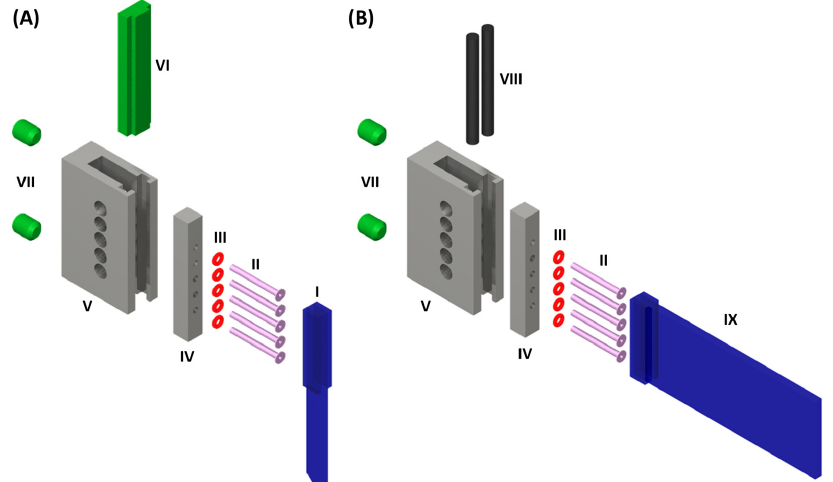
Figure 4. Exploded view scheme of the connector interfacing fluidic devices and the tubing: ( A ) Fluid connector assembly for DMPT. ( B ) Fluid connector assembly for other planar microfluidic devices. (I) Droplet sampling tool; (II) Flanged PTFE-Tubing (1/16” OD, 0.5 mm ID, ca. 4 mm flange radius); (III) Rubber O-rings; (IV) Aluminum crossbars with through holes for the tubing; (V) Aluminum main frame with side openings for visual adjustment of tube to device alignment. Tapped holed for the grub screws (VII) and groove inside for the plastic support (VI) for the fluidic device. (VIII) Rubber sealing cord, (IX) planar microfluidic chip with fluid inlets on the face-side. The fluidic devices (I) and (IX) are planar due to their manufacturing process and must be supplemented by rectangular glass plates to fit in the connector. The supporting glass plates were glued onto the outsides of the fluidic devices in the area using a photo adhesive.